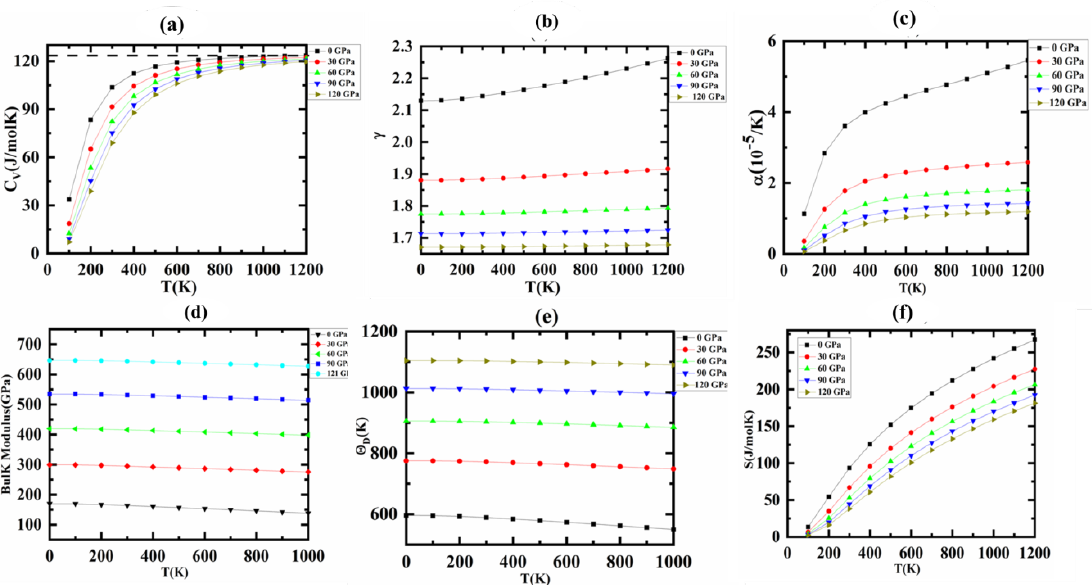
Figure 7. ( a ) Specific heat, ( b ) Grüneisen parameter, ( c ) thermal expansion coefficient, ( d ) bulk mod- ulus, ( e ) Debye temperature, ( f ) Entropy vs. Temperature of cubic SnTiO 3 obtained using the nmBJ-GGA method.